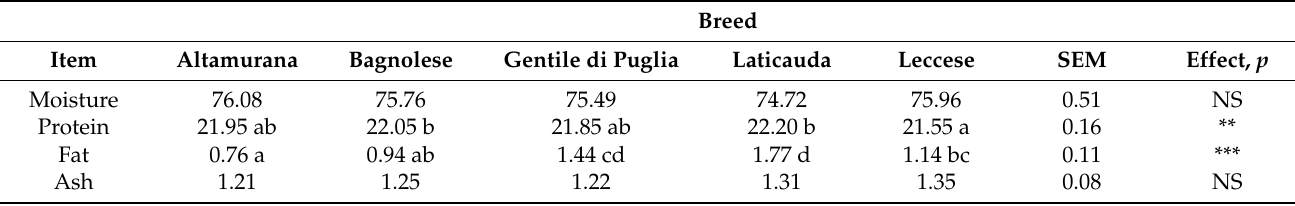
Table 2. Chemical composition (%) of Longissimus lumborum (LL) muscle of lambs from five sheep breeds reared in continental Southern Italy (means ± SEM).